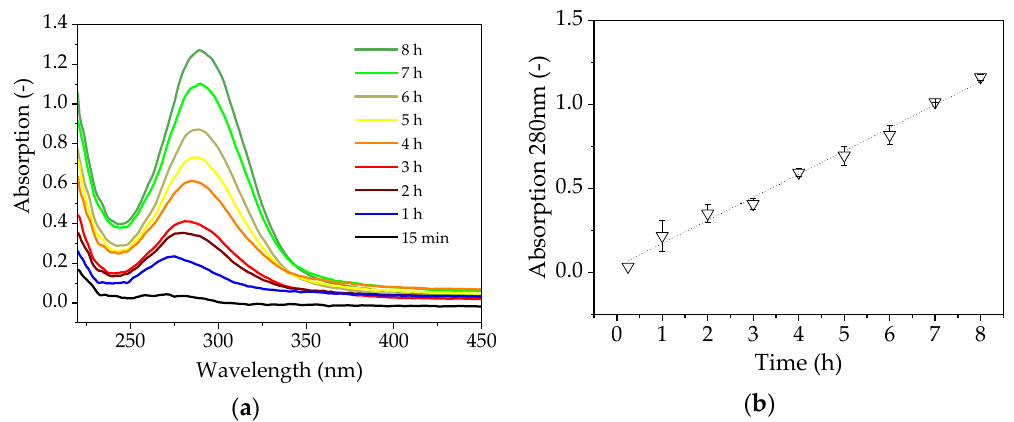
Figure 6. ( a ) Absorption spectrum of enzyme catalysis in the beaker for 8 h. ( b ) Linear increase in absorption at 280 nm.